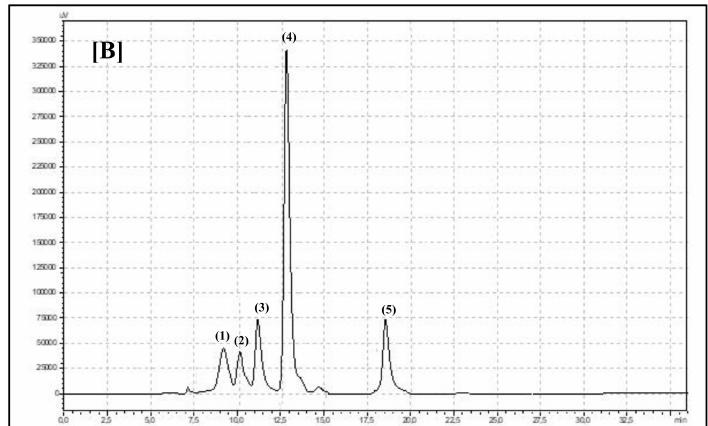
Figure 3. Chromatogram showing retention times for anthocyanins identified in flowers of (B) Robinia hispida : (1) malvidin-3- O -glucoside, (2) peonidin-3- O -glucoside, (3) cyanidin-3- O -glucoside, (4) pelargonidin-3- O -glucoside, and (5) delphinidin-3- O